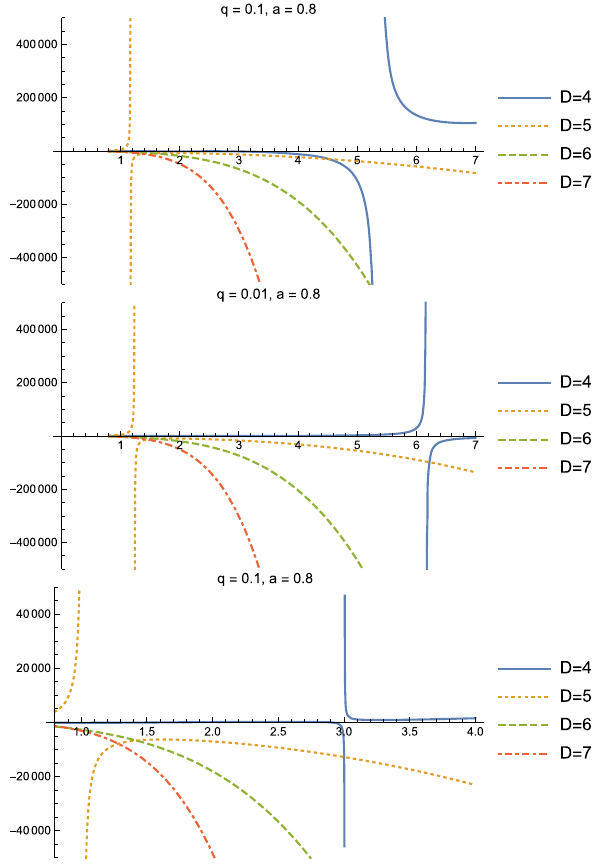
Fig. 13 Heat capacity in Gauss–Bonnet gravity as function of r h , for a = 0 . 8 and q = 0 . 1